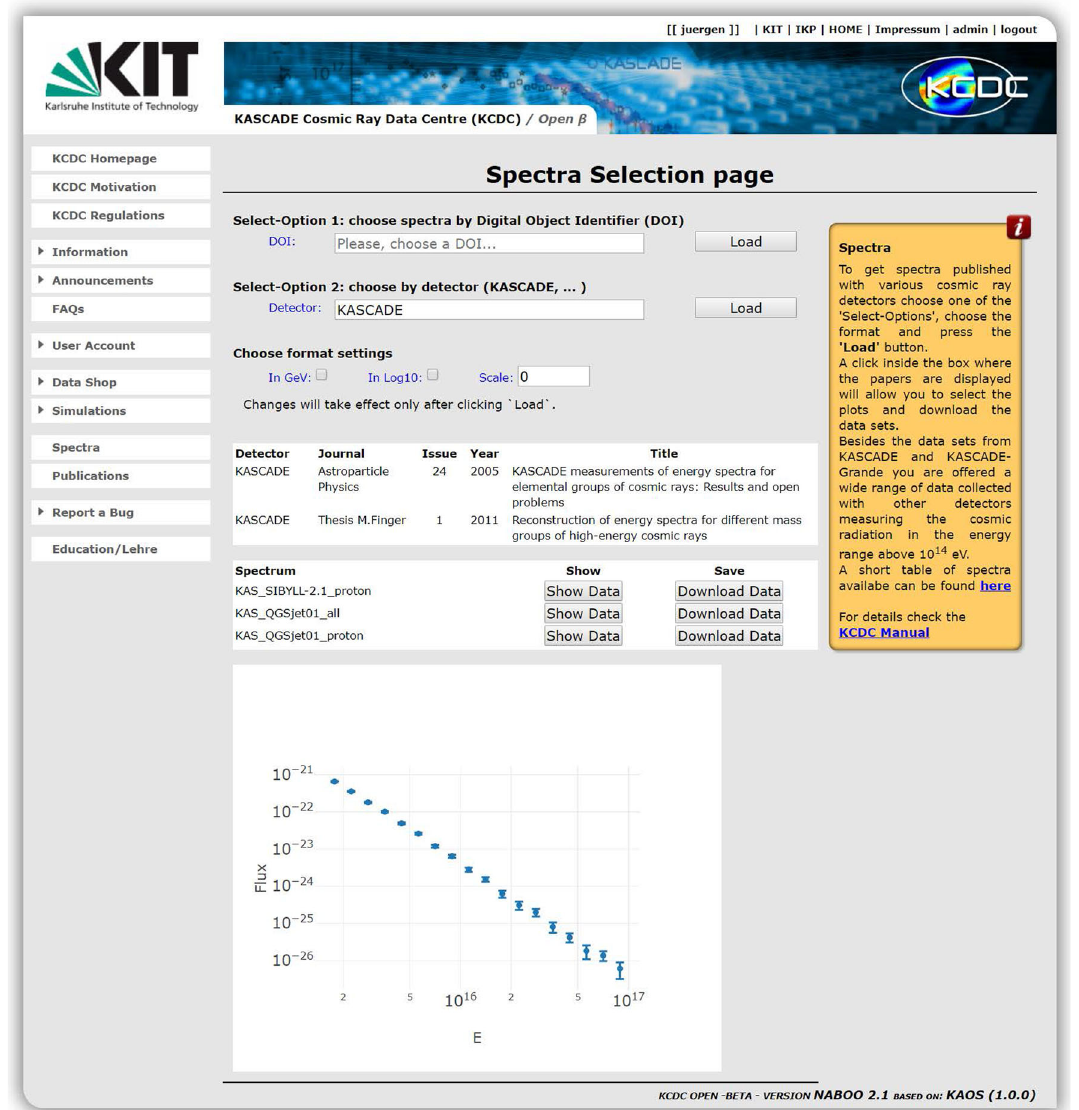
Fig. 10 Example of a spectrum ready for download